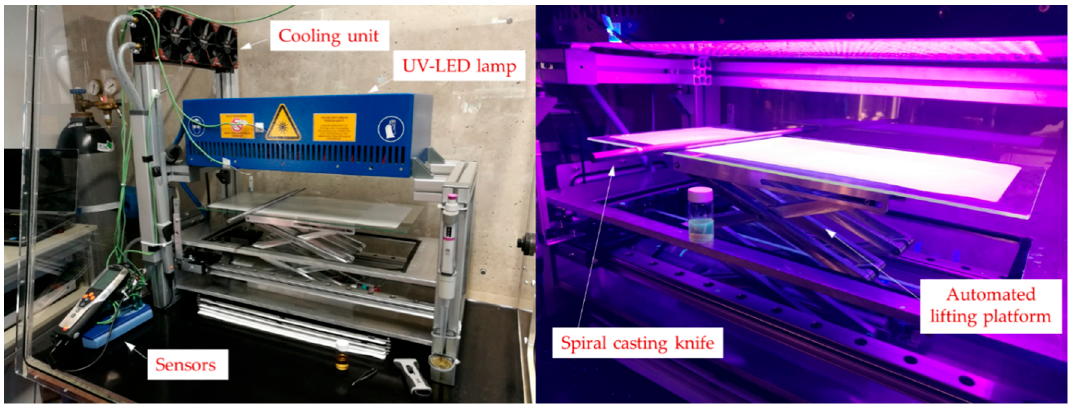
Figure 2. Automated membrane casting coating machine (right: irradiation).